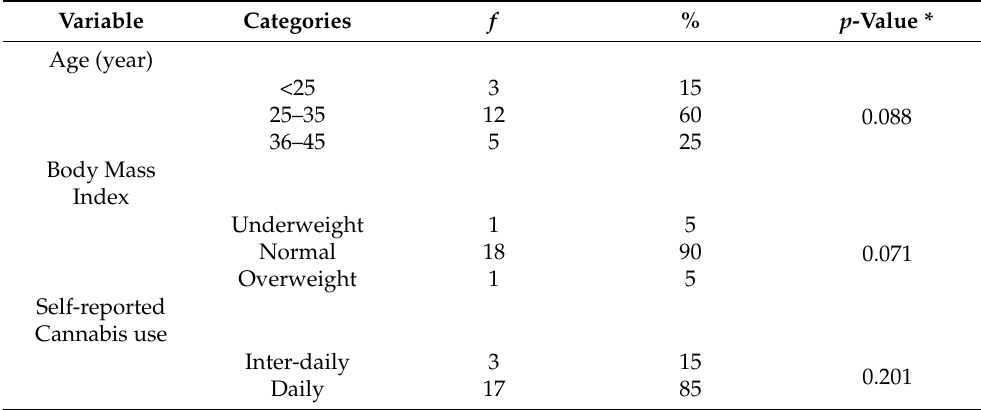
Table 1. Baseline characteristics of cannabis users (n = 20). * significant p < 0.05.